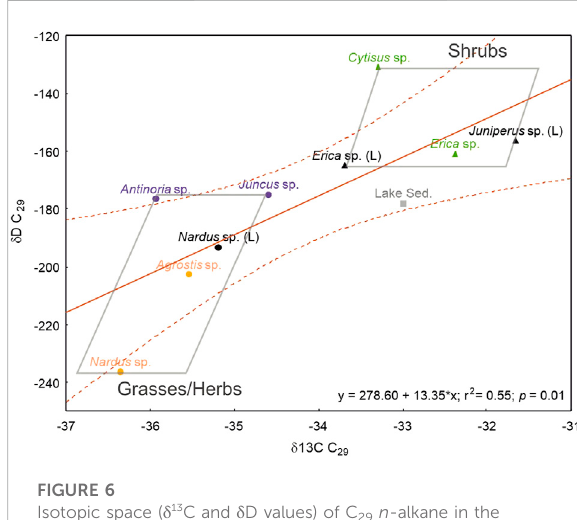
FIGURE 6 Isotopic space ( δ 13 C and δ D values) of C 29 n -alkane in the analyzedsamplesfromtheLakePeixãoarea.Circlescorrespondto samples form grass/herb ecological forms, where blue circles relate to aquatic-related plants and yellowish circles relate to nonaquatic-related plants; triangles correspond to samples from shrub ecological forms (L) indicating litter sample from the respective plant. Lake Sed. (black square) corresponds to the surface lake sediment